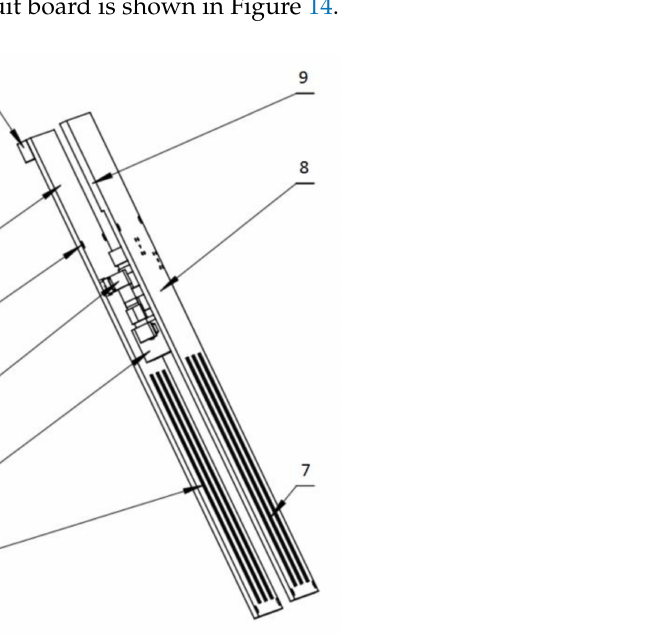
Figure 13. Differential circuit board structure diagram: 1. Temperature and humidity detection module. 2. Signal source circuit. 3. Location hole. 4. The radio frequency (rf) elbow. 5. Power splitter 6. Detection unit 2. 7. Detection unit 1. 8. Circuit board. 9. Main